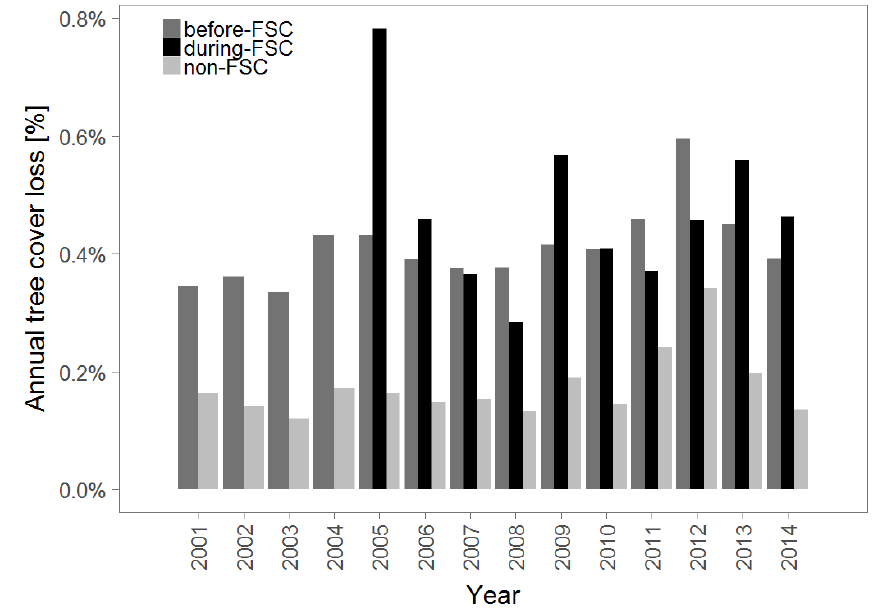
Figure 6. Annual tree cover loss between 2001 and 2014 [50] within and outside of FSC-certified areas in the Arkhangelsk Region. ‘Before-FSC’ refers to concessions where tree cover loss occurred before FSC-certificates were issued; ‘during- FSC’ indicates tree cover loss that happened while FSC-certificates were valid; non-FSC covers areas for which no FSC-certificates were available throughout this period.